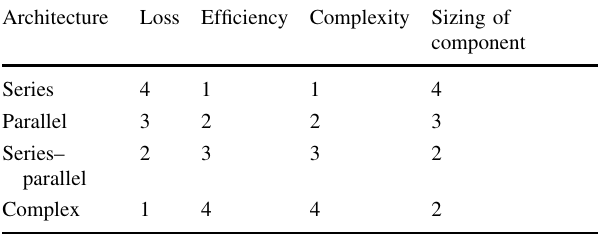
Table 4 Summary on